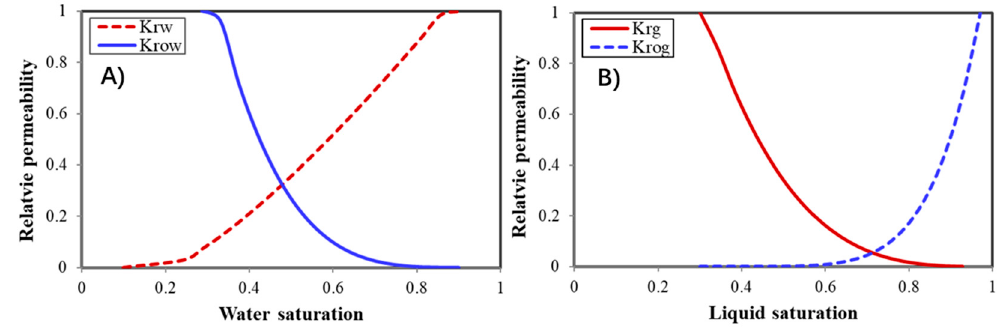
Figure 6. Relative permeability curves from history matching results. ( A ) Water-oil; ( B ) Liquid-gas.